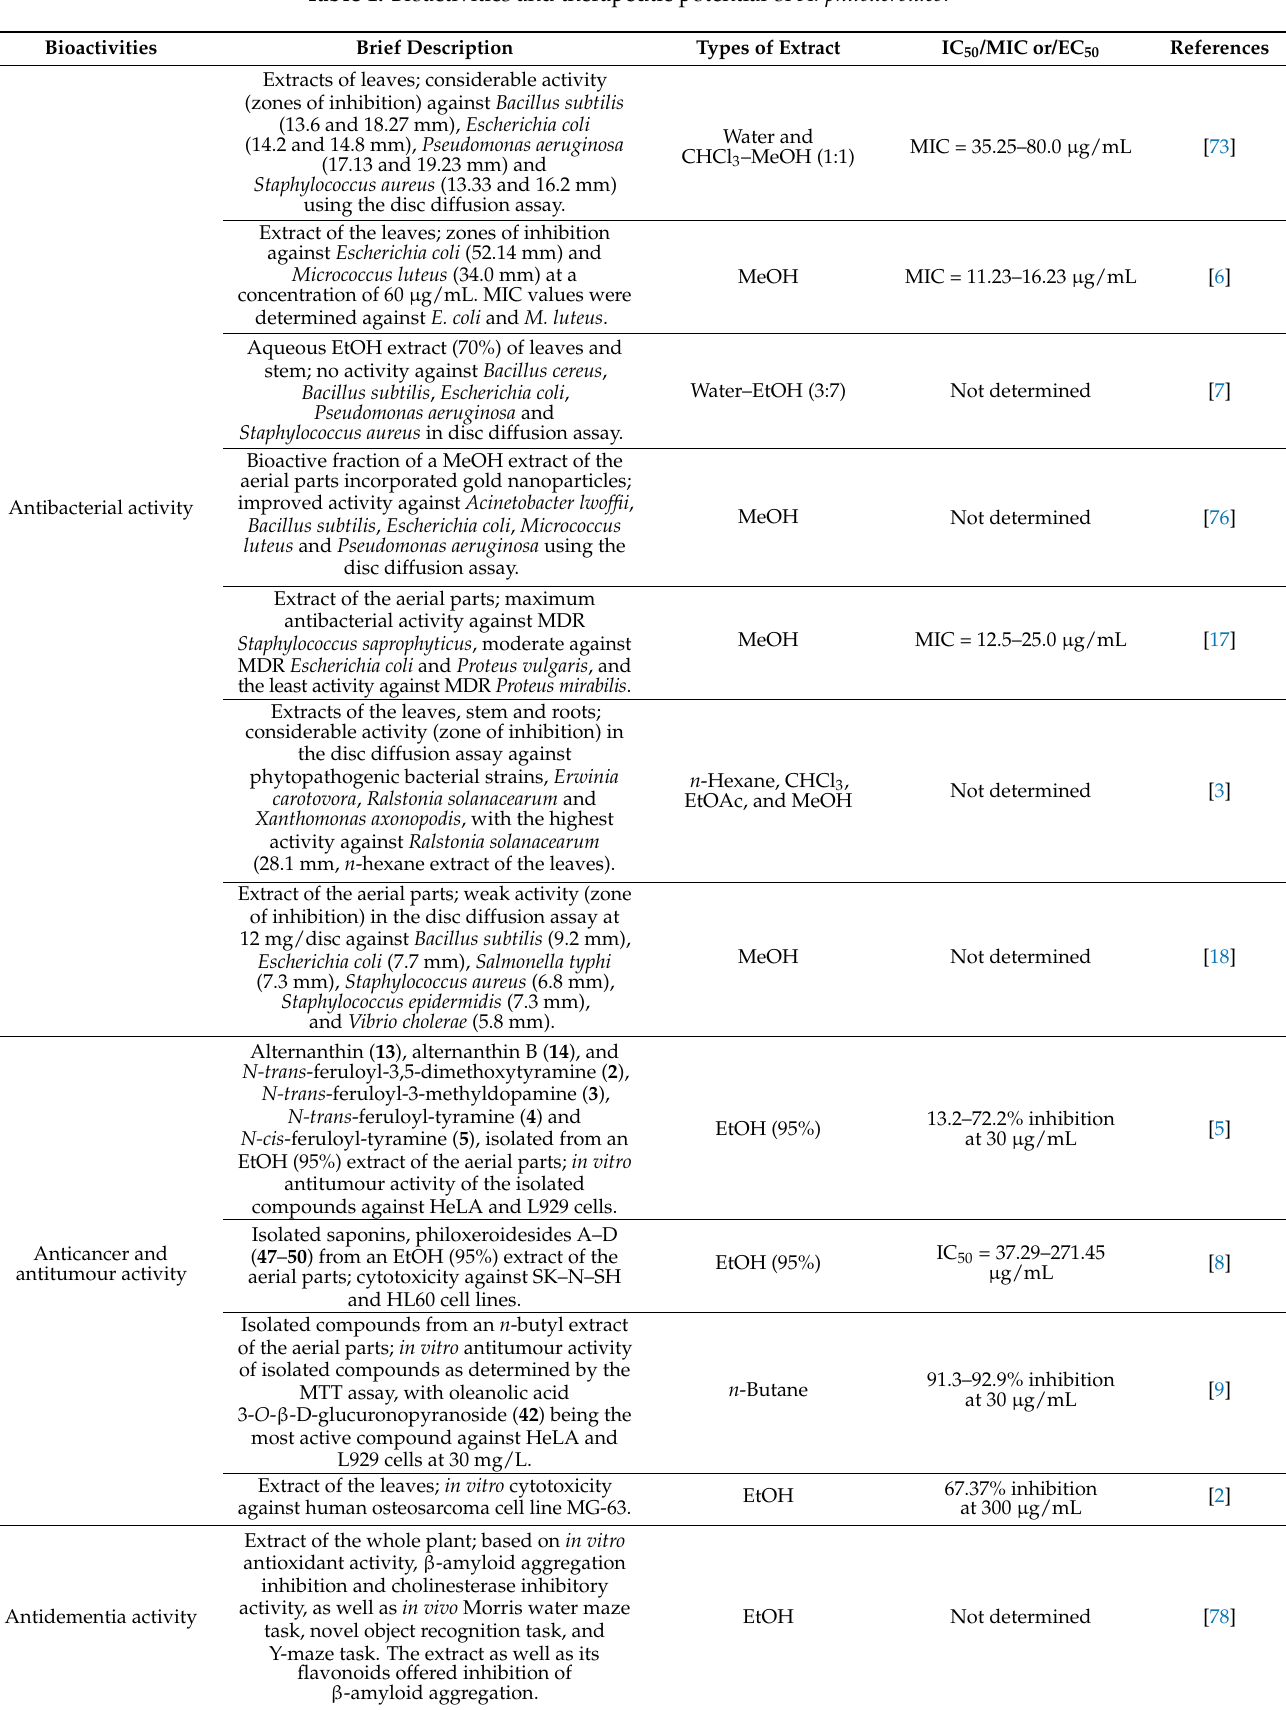
Table 1. Bioactivities and therapeutic potential of A. philoxeroides